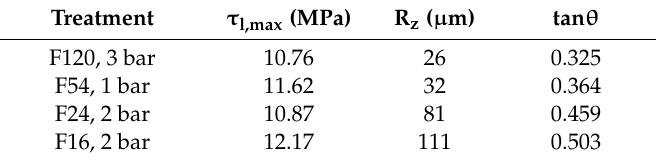
Table 7. Change in test results and roughness parameters (blasting (3 bar) → combined blasting (3 bar) and etching (5 min, NaOH) treatment, 5 µm tip).